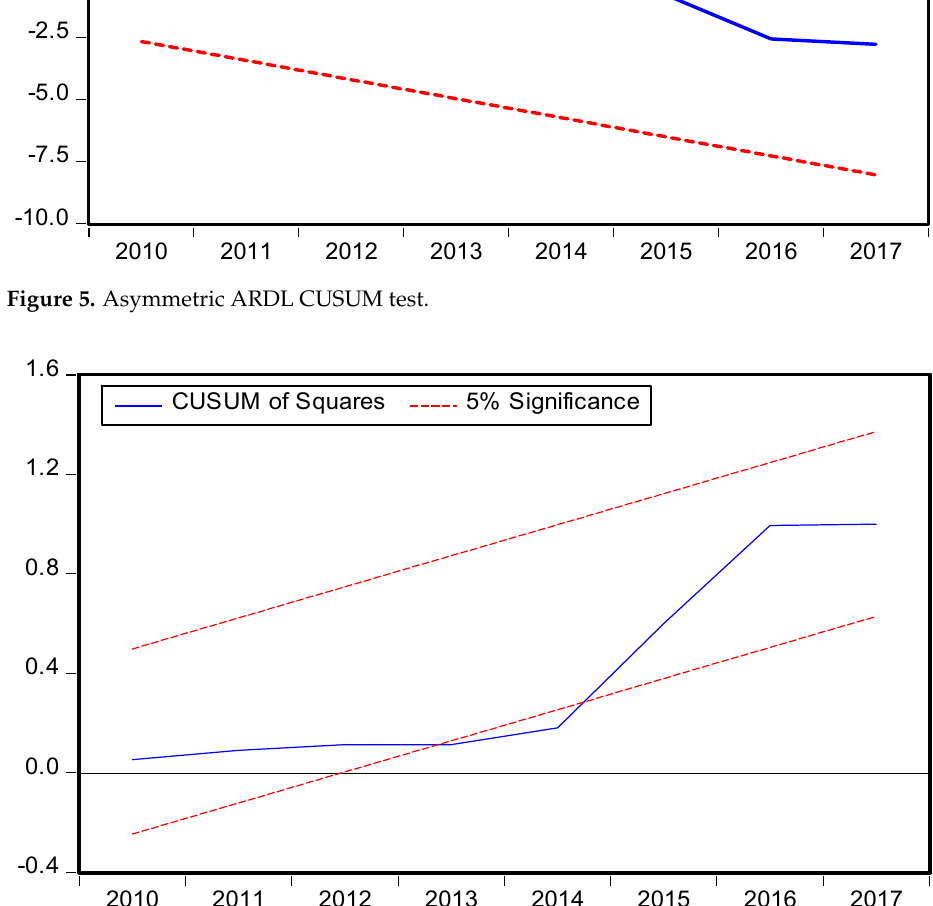
Figure 6. Asymmetric ARDL CUSUM of Squares test.